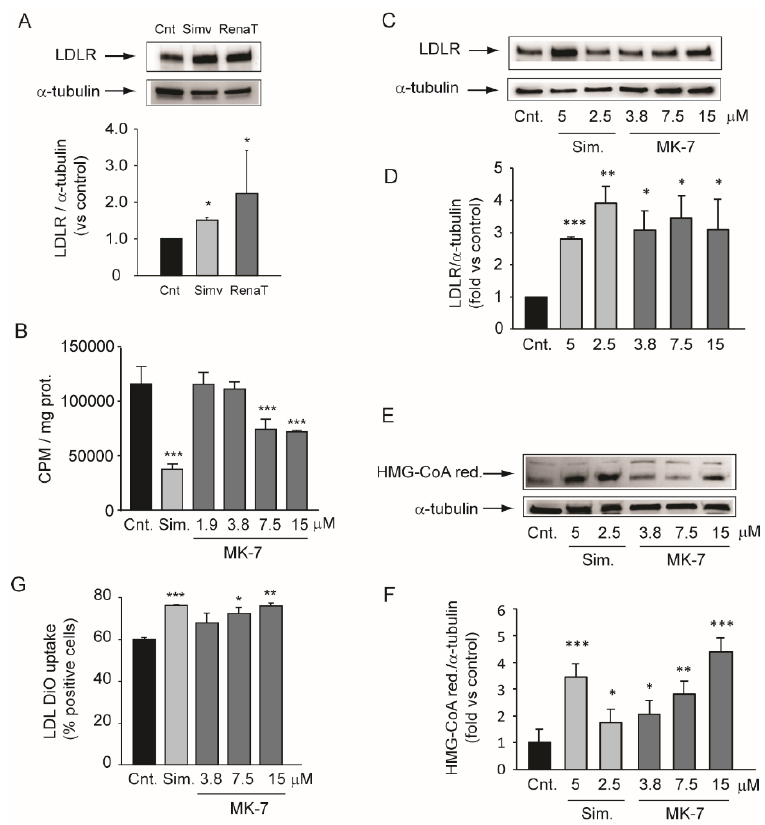
Figure 2. E ff ect of MK-7 on cholesterol synthesis and low-density lipoprotein (LDL) uptake. ( A ) Human hepatoma cells were incubated with simvastatin (5 µ M) and ethanol extract of RenaTris ® (RenaT), as indicated in the Materials and Methods section. After 24 h, total protein extracts were prepared and low-density lipoprotein receptor (LDLR) expression was determined by Western blot analysis. α -tubulin was used as the loading control. ( B ) Human hepatoma cells were cultured in minimum essential medium (MEM) containing [2- 14 C]-acetate in the presence or absence of indicated concentrations of MK-7 or simvastatin (5 µ M) as the positive control. [2- 14 C]-acetate incorporation was used to assay cholesterol biosynthesis 24 h after addition to cells. Each point represents the mean ± SD of triplicate dishes. ( C , E ) Human hepatoma cells were incubated for 24 h with indicated concentrations of simvastatin and MK-7. LDLR and HMG-CoA reductase protein expression were evaluated by Western blot analysis. α -tubulin was used as the loading control. ( D , F ) Densitometric readings were evaluated using the ImageLab TM software. ( G ) Cells were seeded in MEM / 10% fetal calf serum (FCS) and incubated the next day with MEM / 0.4% FCS in the presence or absence of MK-7 and simvastatin (5 µ M). After 24 h, 10 µ g / mL of LDL-DiO was added to the cultured media and the fluorescence intensity was determined by flowcytometry analysis after 3 h of incubation. Data are given as the mean ± SD of triplicate dishes. Di ff erences between treatments were assessed by Student’s t test. * p < 0.05 vs. control; ** p < 0.01 vs. control; *** p < 0.001 vs. control. Sim.: